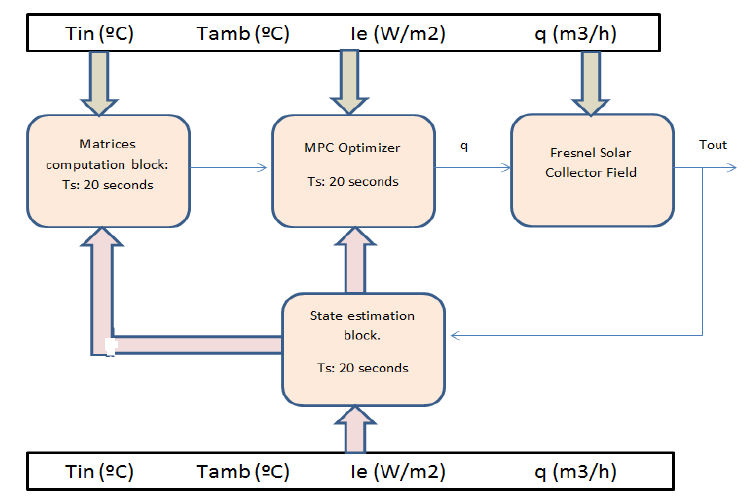
Figure 10. Final Control